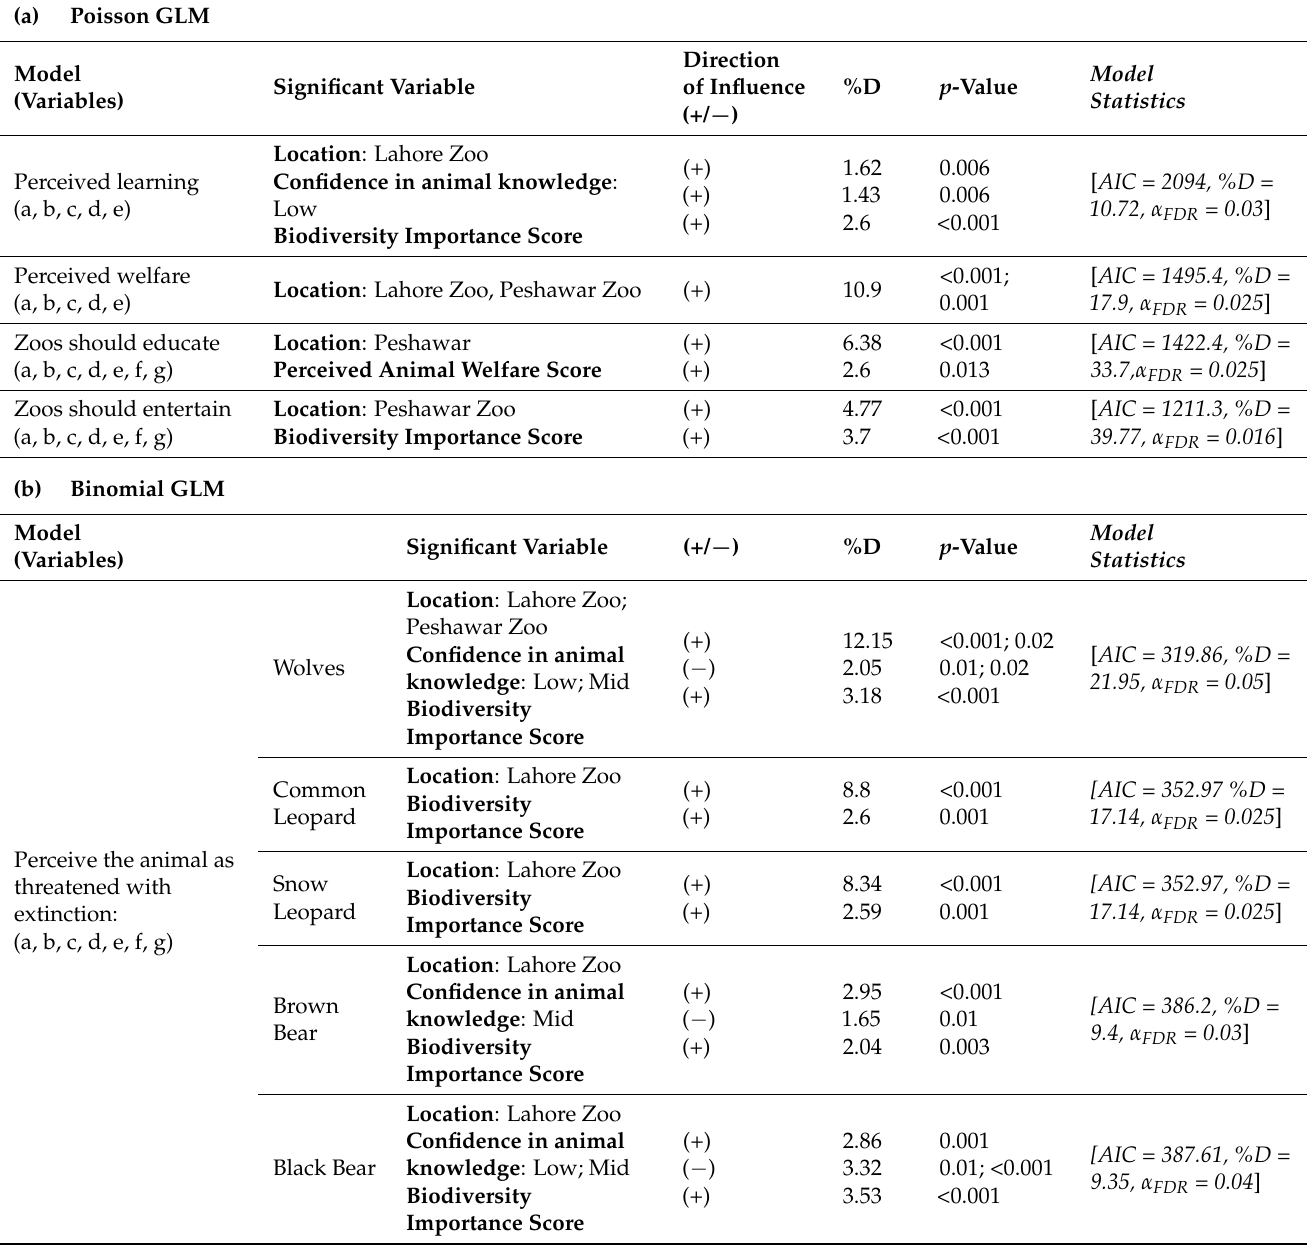
Table 1. Minimum adequate models (MAMs) demonstrating significant predictor variables for visitors’